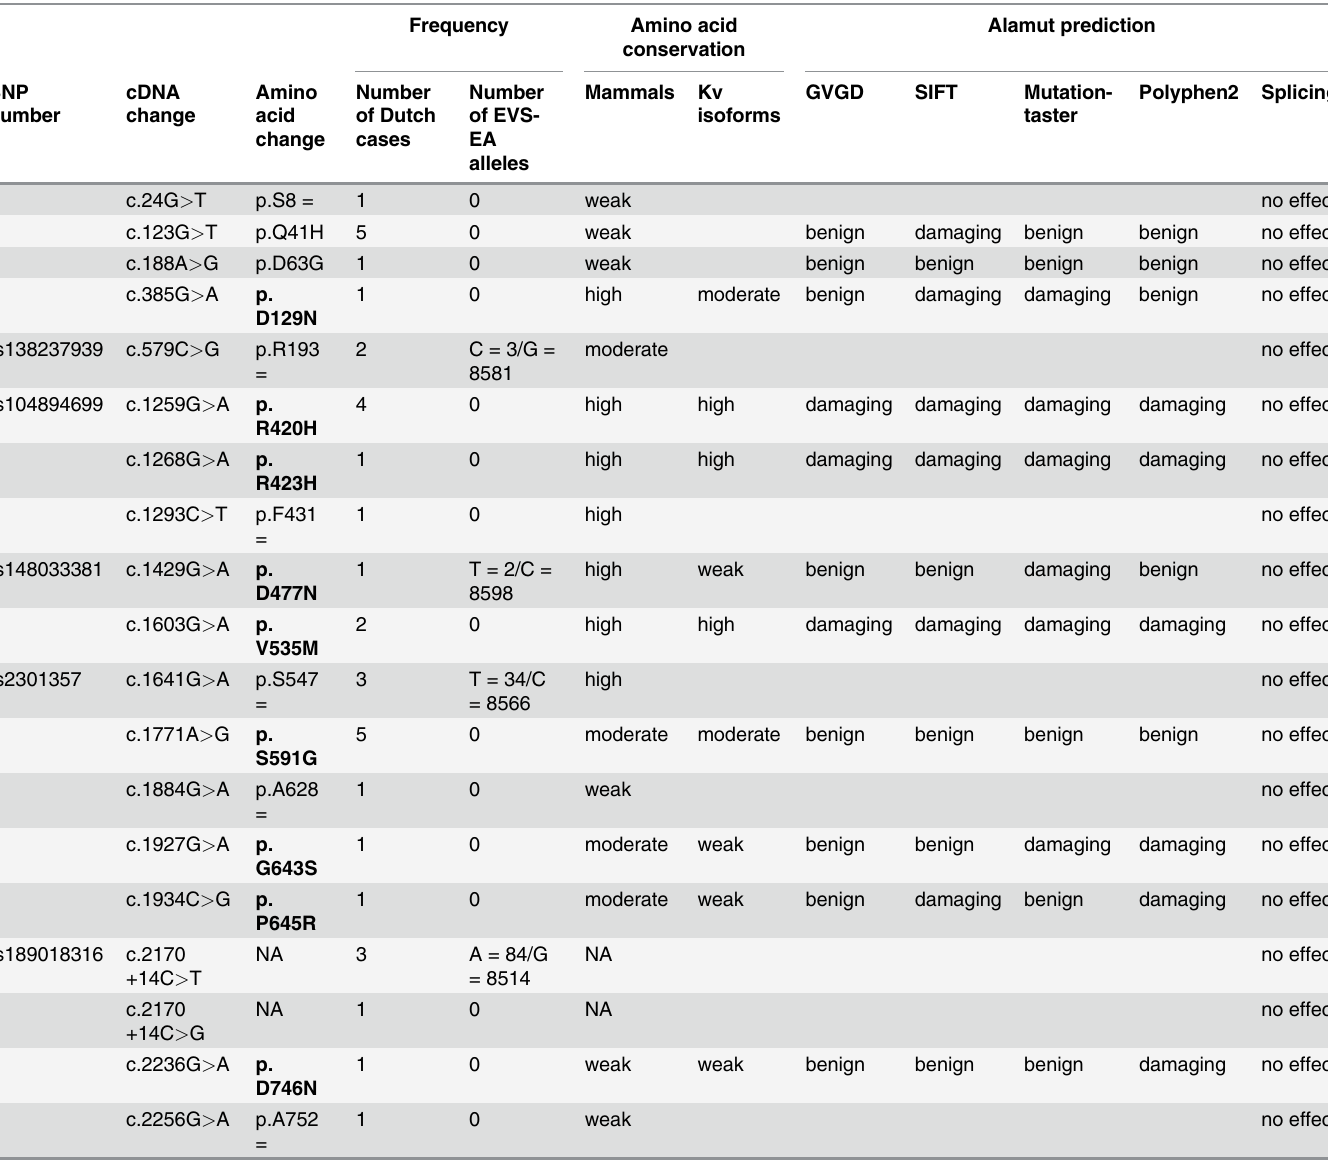
Table 1. List of all identi fi ed genetic variations in KCNC3